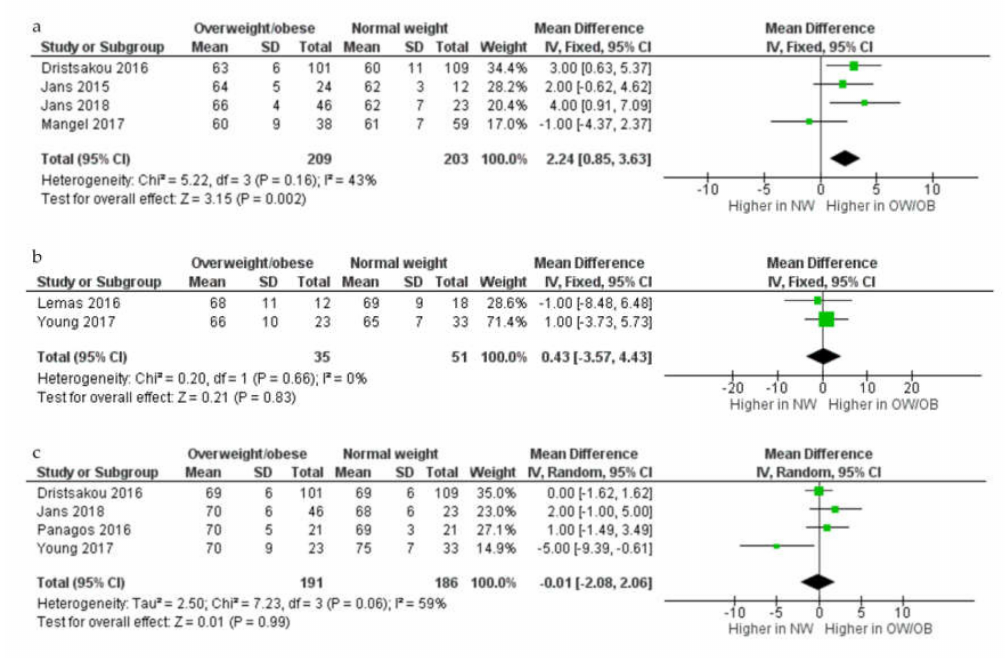
Figure 4. Comparison of lactose concentration (g / L) from normal weight and overweight and obese women according to stage of lactation, colostrum ( a ), transitional ( b ), and mature ( c ). CI, confidence interval; Chi 2 and I 2 , measures of heterogeneity; IV, inverse variance; NW, normal weight women; OB, obese women; OW, overweight women; SD, standard